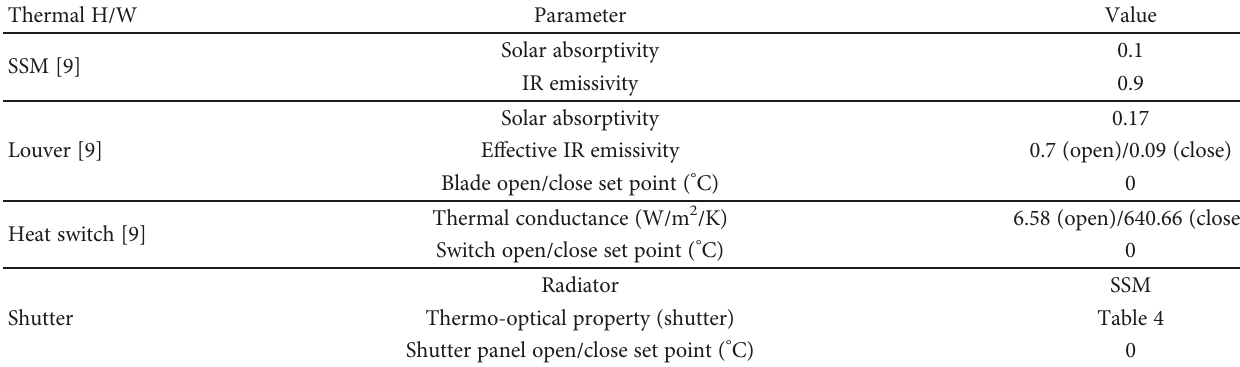
Table 3: Thermal properties of thermal control